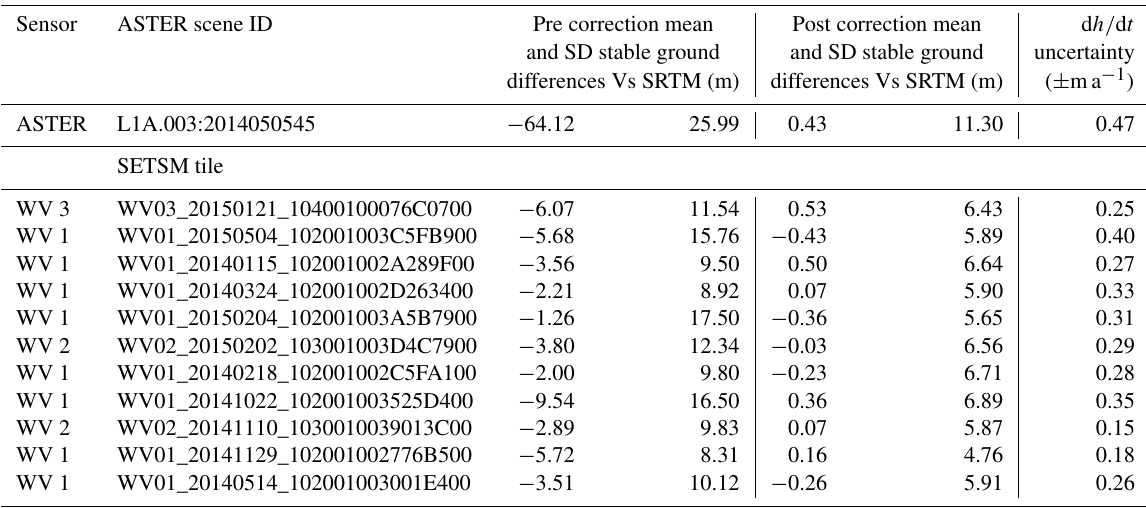
Table 2. Mean differences and the standard deviation associated with off-glacier elevation difference data between ASTER, SETSM and SRTM DEMs before and after the DEM correction process. The uncertainty associated with DEM difference data (sum of standard error estimates for each 100m elevation bin of difference data) is also listed for each SETSM and ASTER